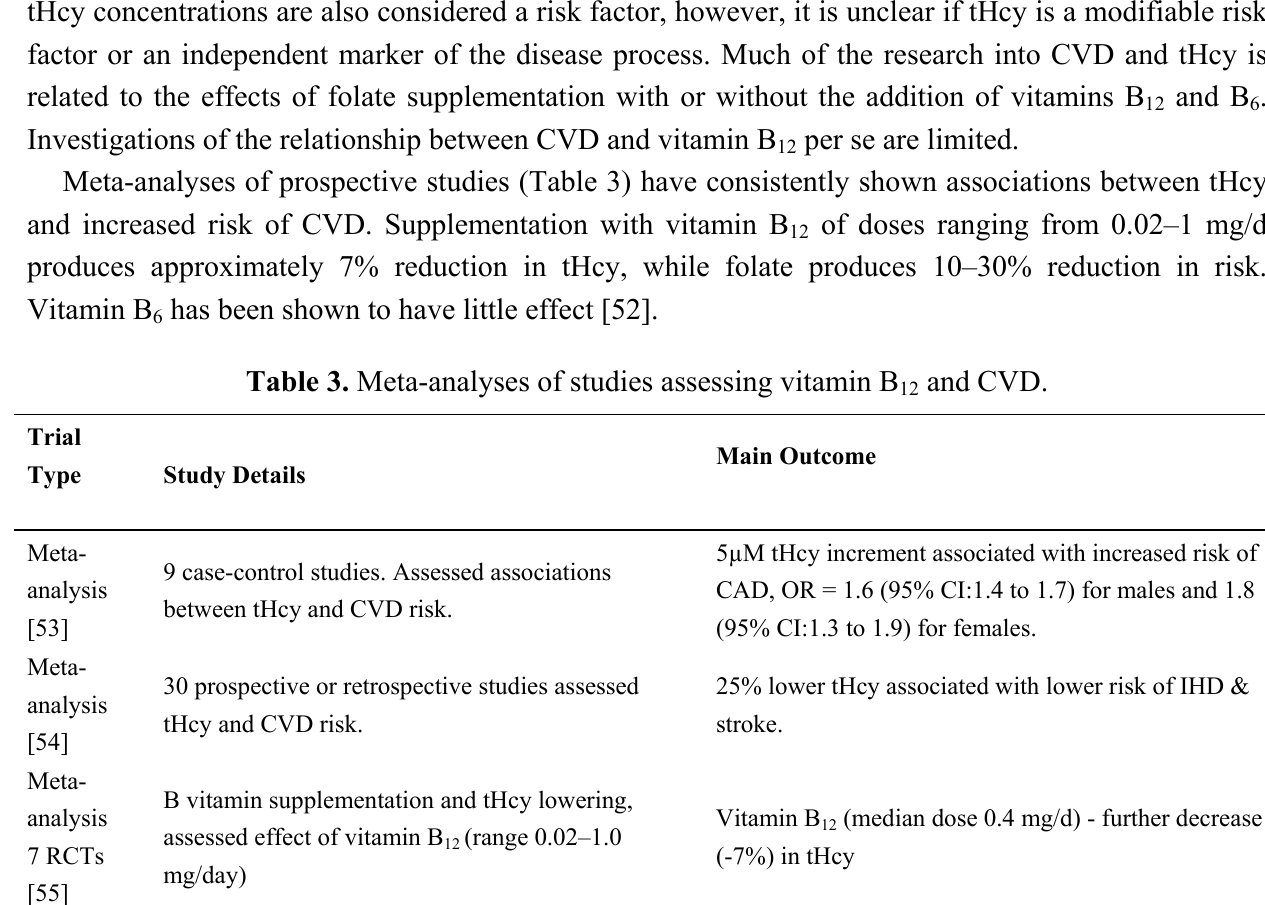
Table 3. Meta-analyses of studies assessing vitamin B